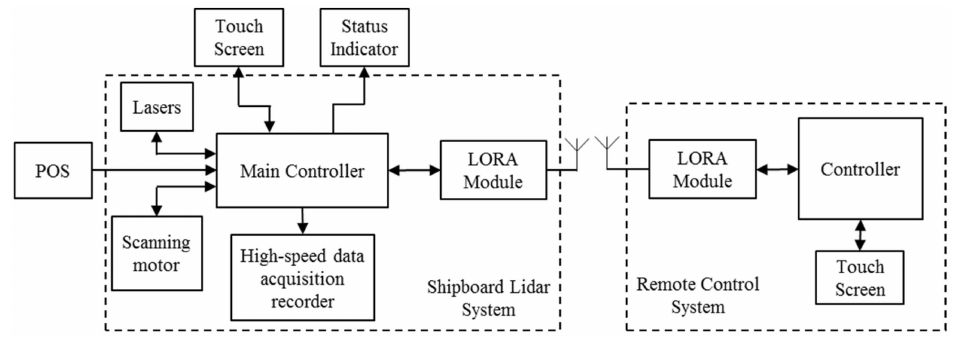
Figure 9. Architecture of the control components in the GQ-Cor 19